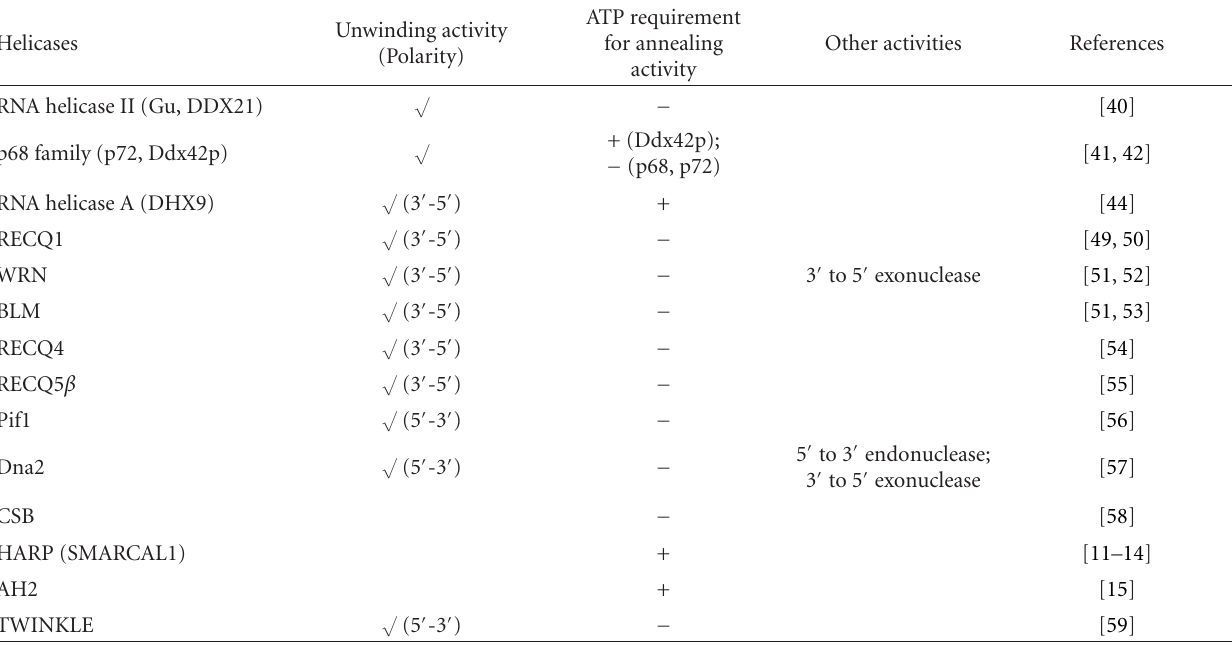
Table 1: Human helicases containing annealing